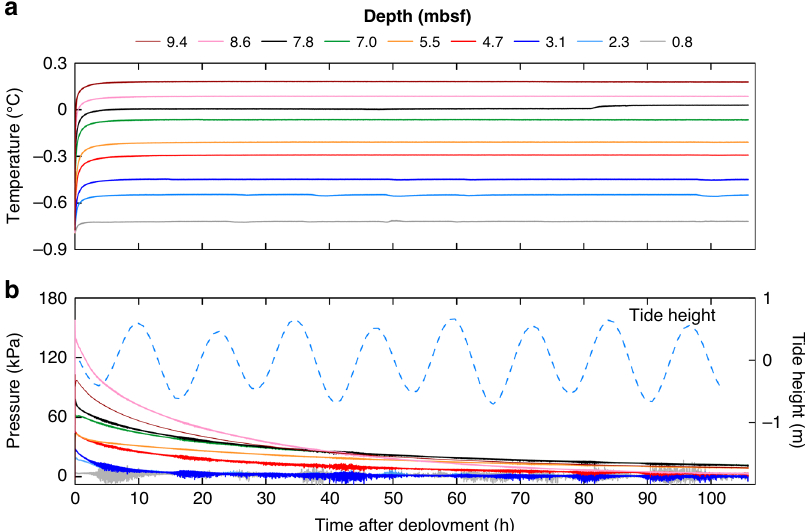
Fig. 3 Data from piezometer site PZM2. a Temperature and b pore pressure versus time. The different colors indicate the depth below the seabed. Sensor depths are between 0.8 mbsf (gray curve) and 9.4 mbsf (brown curve). Tidal heights obtained at the piezometer location from the TPXO 9.0 global tidal model 46,47 are shown as dashed light blue